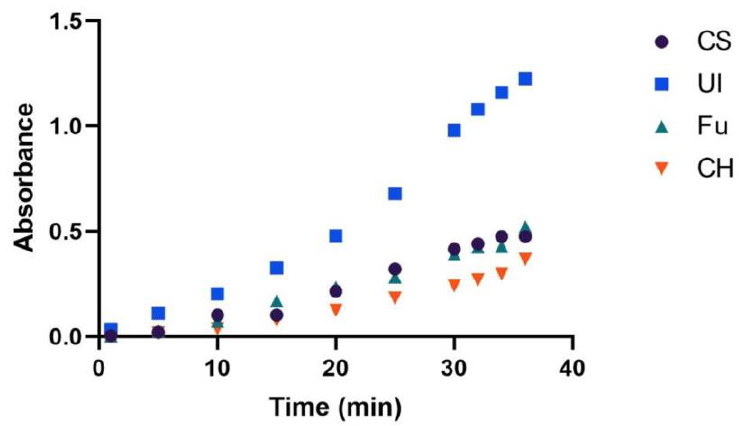
Figure 3. Variation in the absorbance as a function of time in different types of membranes.